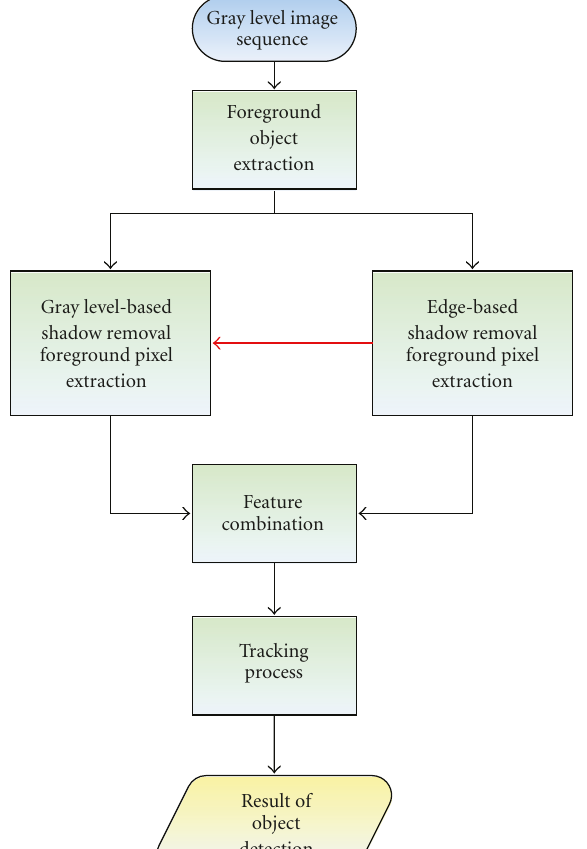
Figure 1: Architecture of the proposed shadow removal